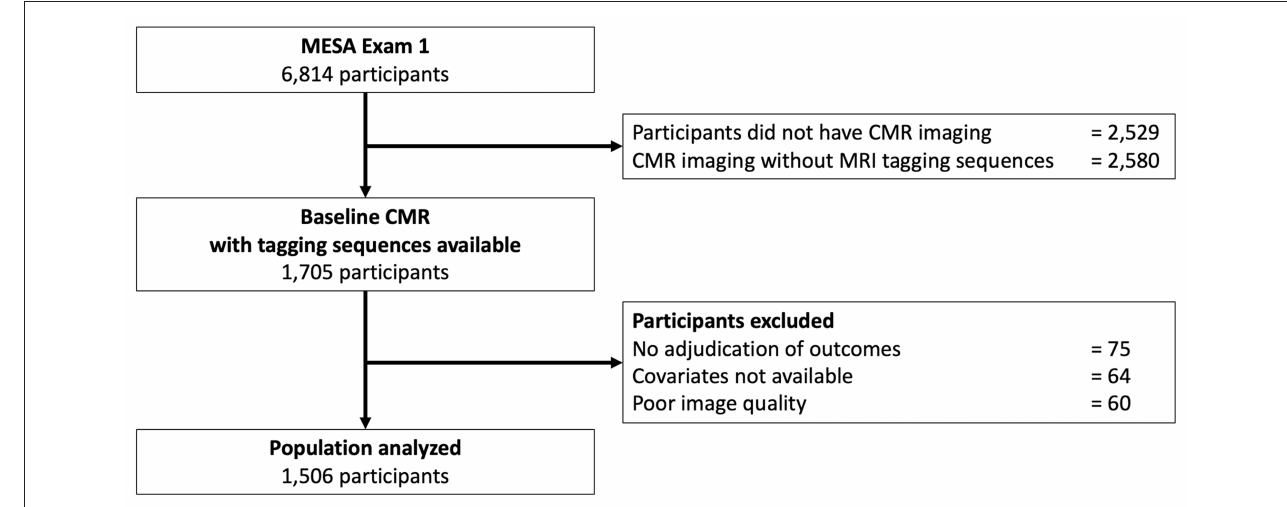
FIGURE 1 | Flowchart of the study. CMR, cardiovascular magnetic resonance; MRI, magnetic resonance imaging.